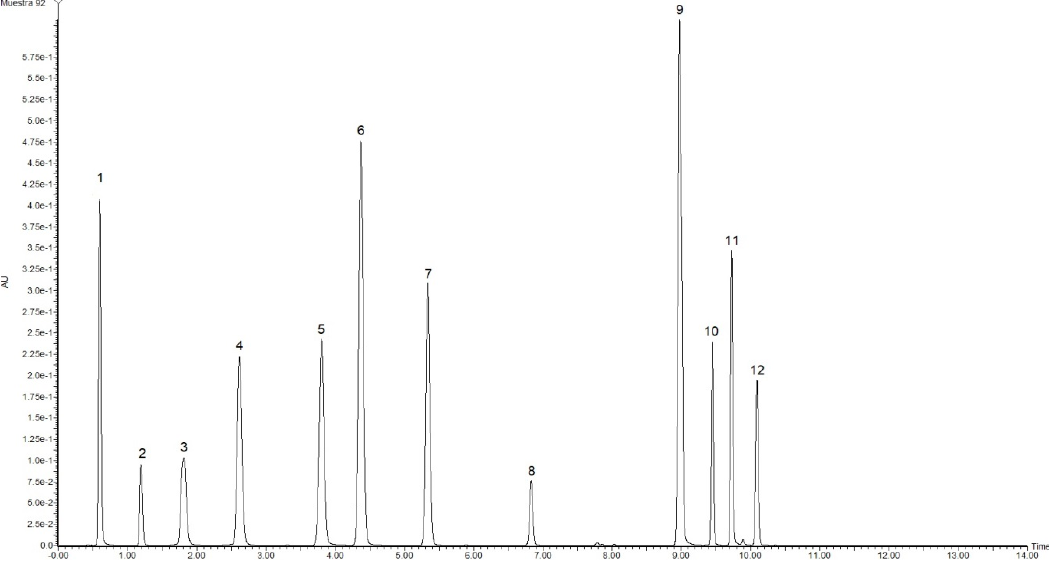
Figure 3. UPLC chromatogram of phenolic compound standards analyzed at 280 nm [y axis = intensity (absorbance unit, AU); x axis = retention time (min). Peaks: 1, gallic acid; 2, resorcinol; 3, chlorogenic acid; 4, caffeic acid; 5, vanillin; 6, coumaric acid; 7, ferulic acid; 8, rutin; 9, naringenin; 10, quercetin; 11, kaempferol and 12, eugenol.